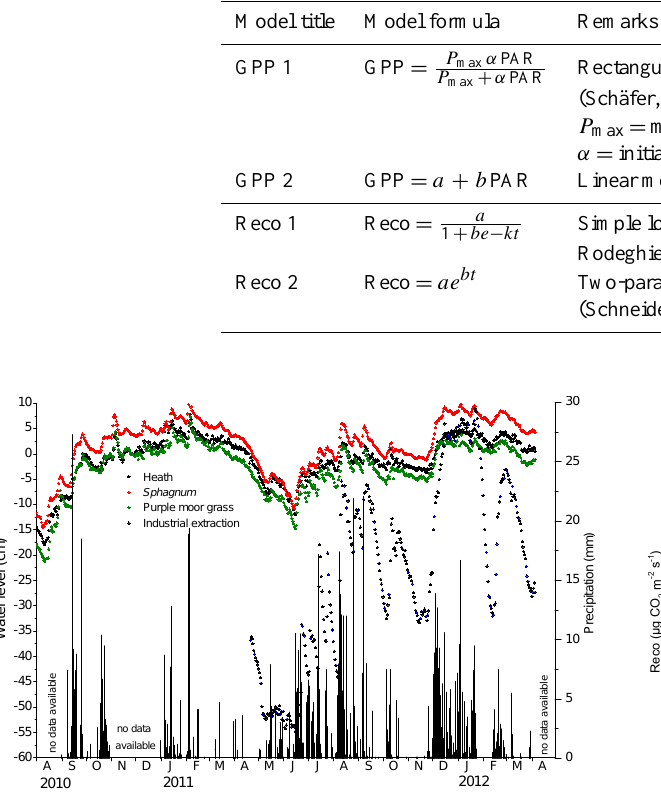
Figure 1. Mean daily water table and daily precipitation at four different bog sites over the whole measurement period from July 2010 until April 2012. No data available for the industrial extraction site before April 2011. Negative values indicate water levels below soil surface and positive values indicate inundation.